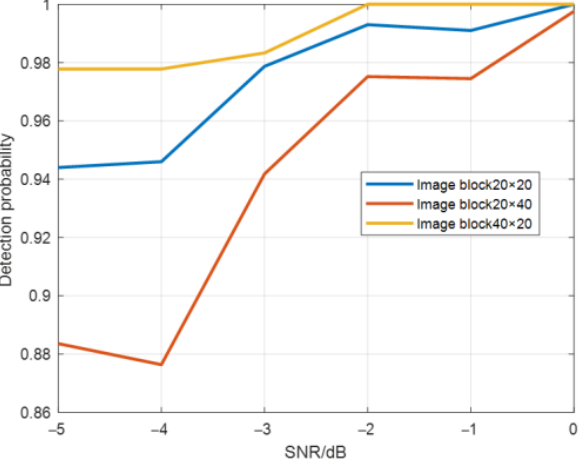
Figure 19. Target detection probability graph using CNN for different image block sizes.